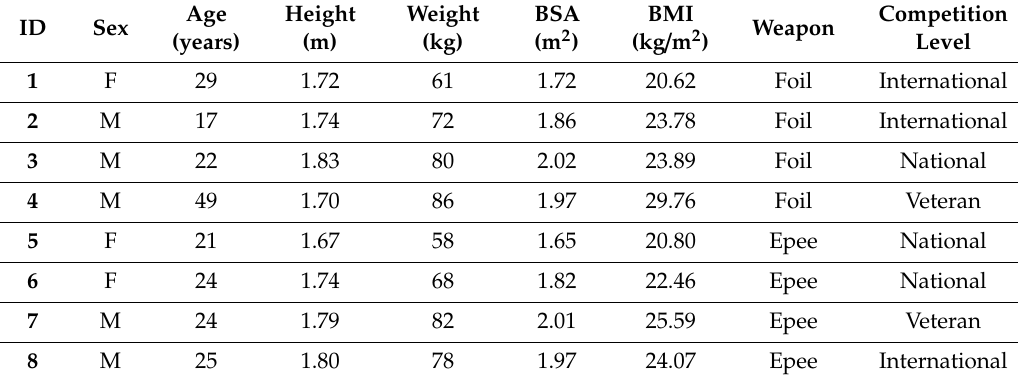
Table 1. Characteristics, weapon performed, and competition level of the eight fencers